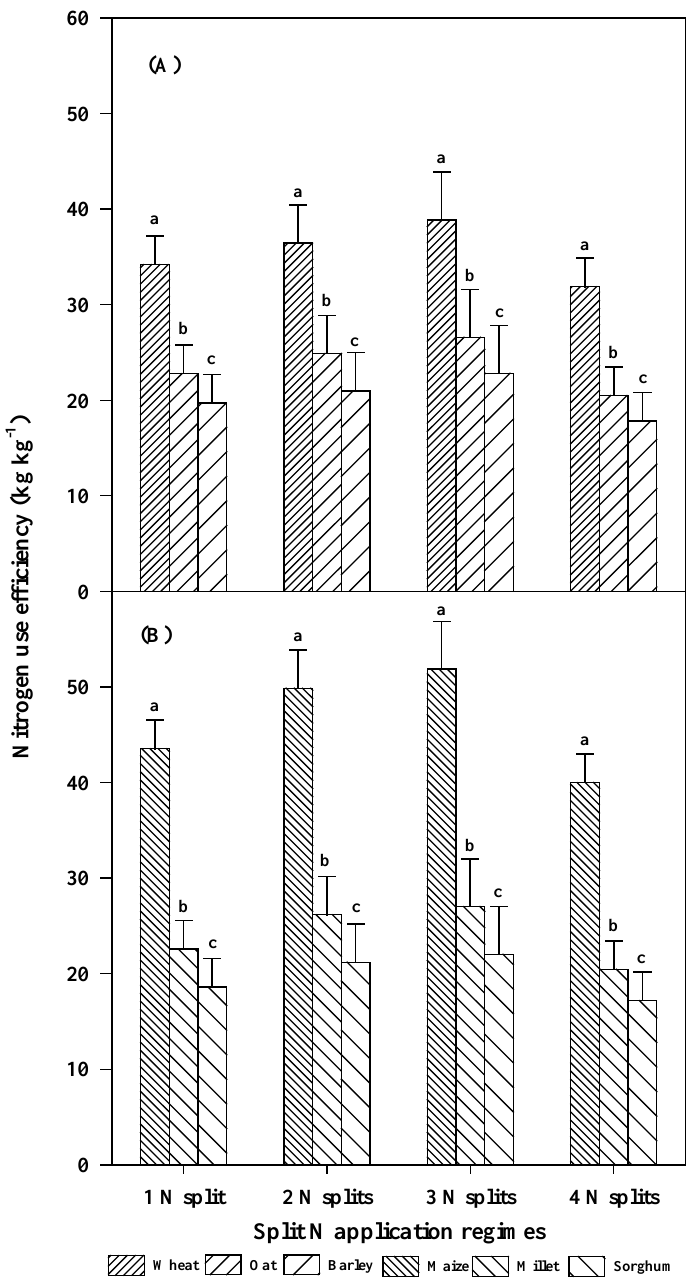
Figure 8. Nitrogen use efficiency (NUE) of C 3 winter (( A ) wheat, oat, and barley) and C 4 summer (( B ) maize, millet, and sorghum) cereals under split N application regimes. Bars represent standard error.